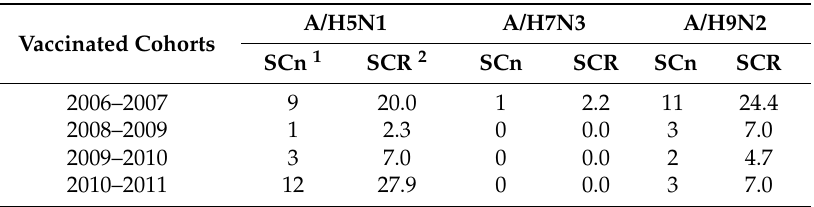
Table 2. Number of seroconversions and seroconversion rate against avian influenza viruses after trivalent influenza vaccine shot in each vaccine campaign cohort.